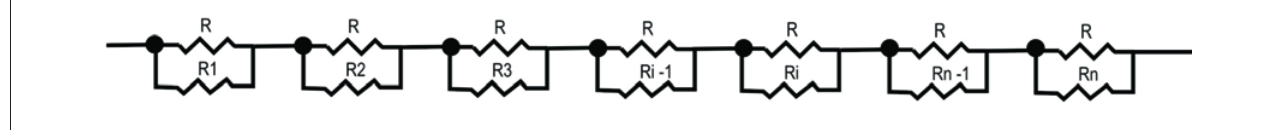
Figure 5 – Transmission lines model described for reinforced concrete and proposed by MACDONALD et al. apud FREIRE [5]